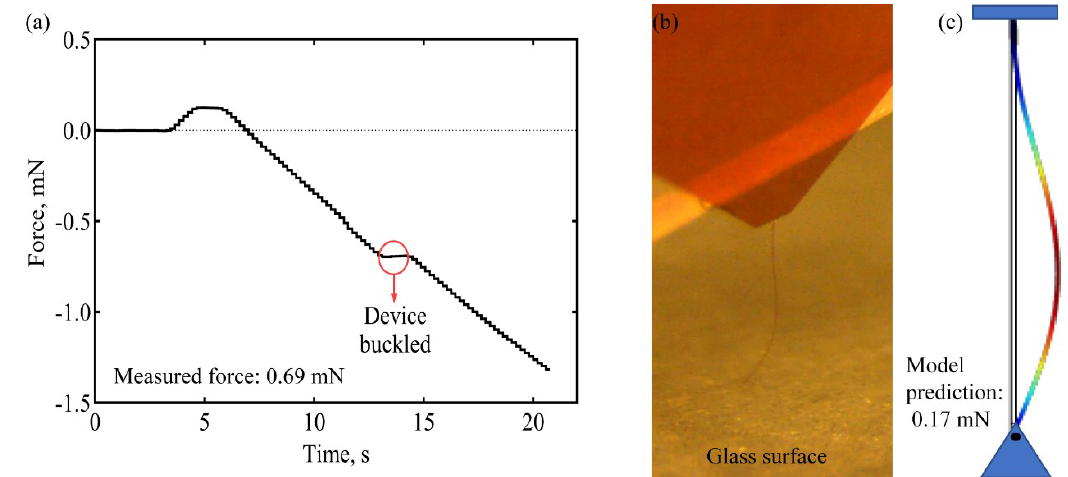
Figure 6. Buckling test. Force measured when a single shank a-SiC probe is lowered against a glass surface ( a ). An image of the buckled state of a 2 mm long shank ( b ) and a COMSOL prediction of the buckled state ( c ).